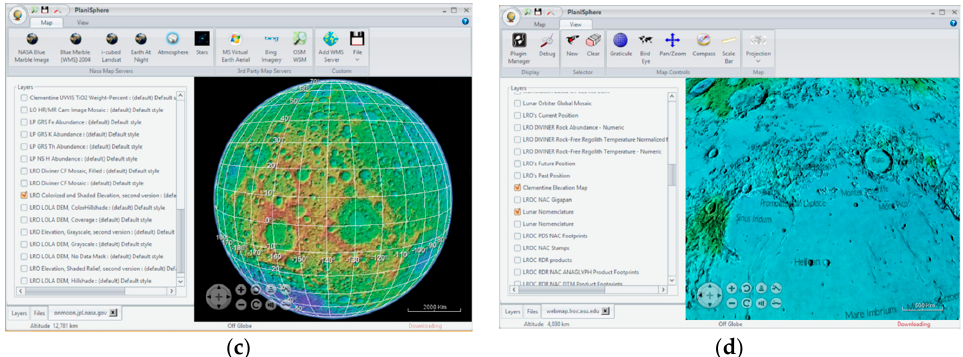
Figure 6. Blue Marble Next Generation imagery and the Moon from the Jet Propulsion Laboratory WMS server: ( a ) Flat-Modified Sinusoidal Projection, ( b ) Mercator Projection, ( c ) Lunar Orbital Mosaic, Colorized and Shaded Elevation by a single layer, and ( d ) A detail view of several points of interest.